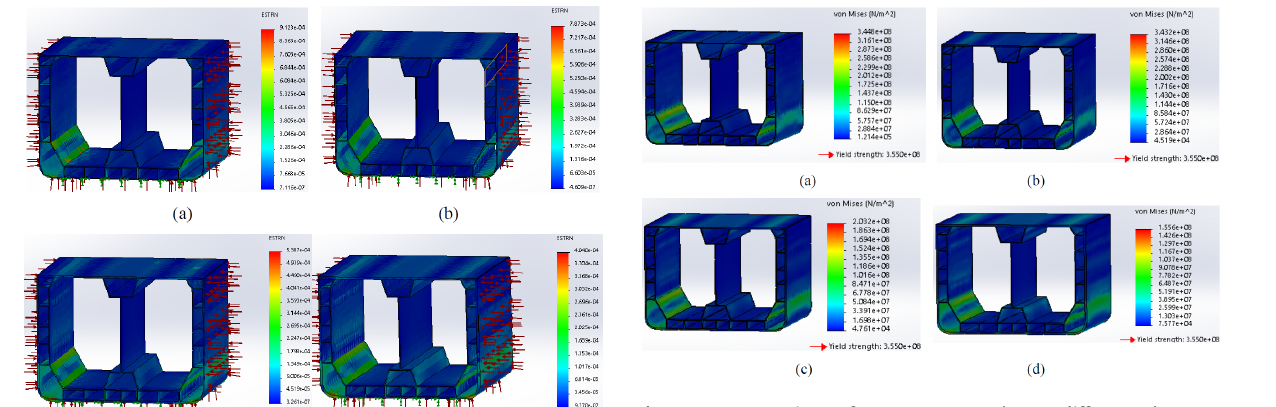
Figure 12: Comparison of stress contour plots at different plate